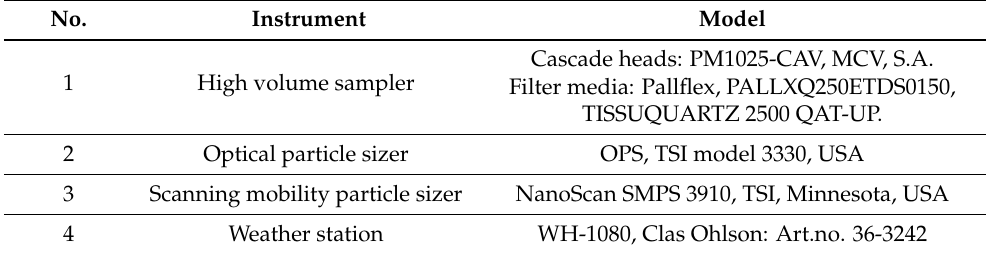
Table 1. General specifications of the ground-based instruments. No. Instrument